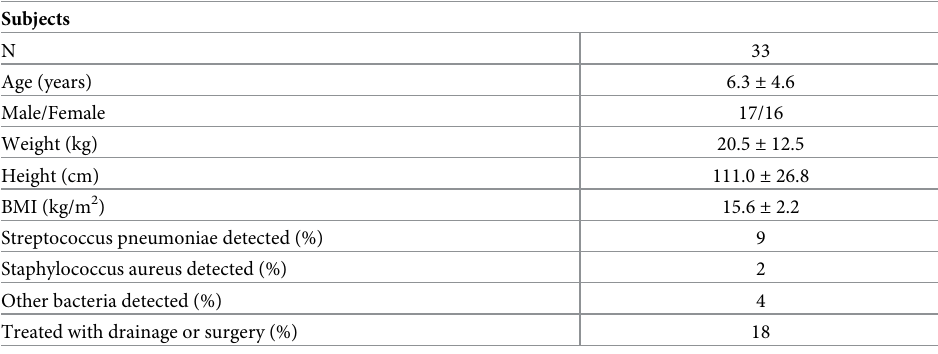
Table 1. Patient